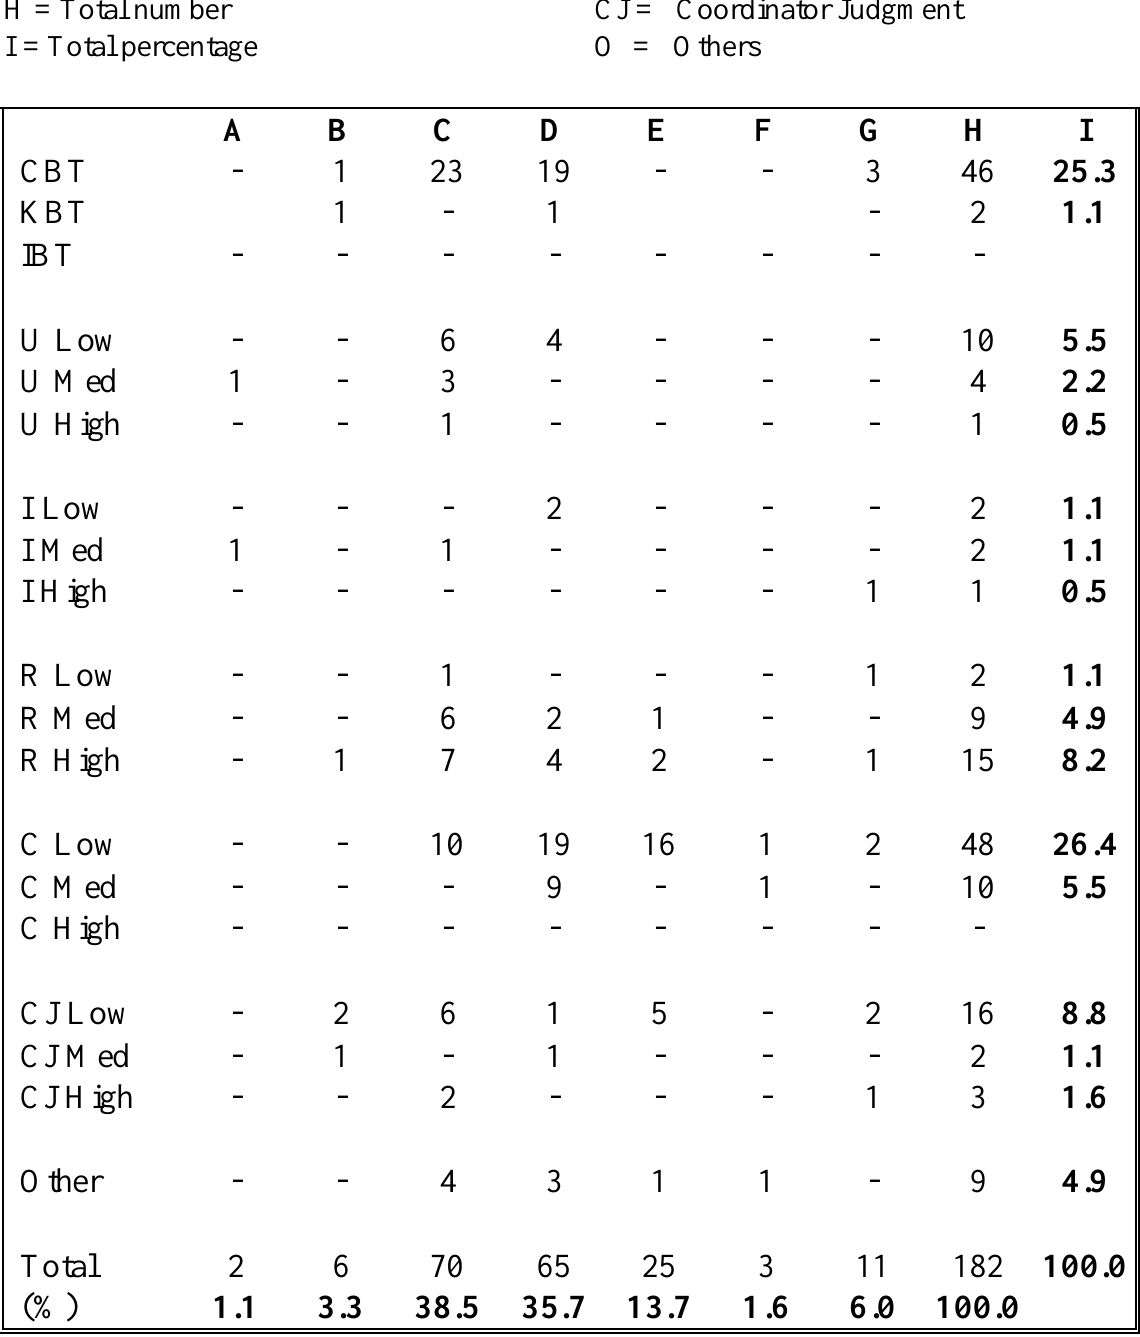
Verbal protocol frequency analysis for 30 American